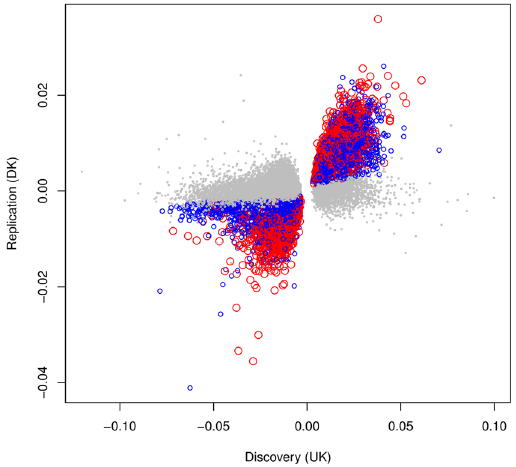
Figure 1. Replication results for the 67,604 significant CpGs identified in the discovery stage. The CpGs coloured with blue and red are the 19,768 CpGs replicated by the Danish cross-sectional twin samples. The red dots represent specifically the 5,168 CpGs double replicated by both Danish cross-sectional and longitudinal